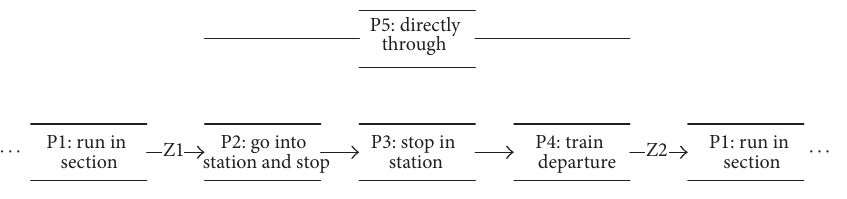
Figure 1: Train operation